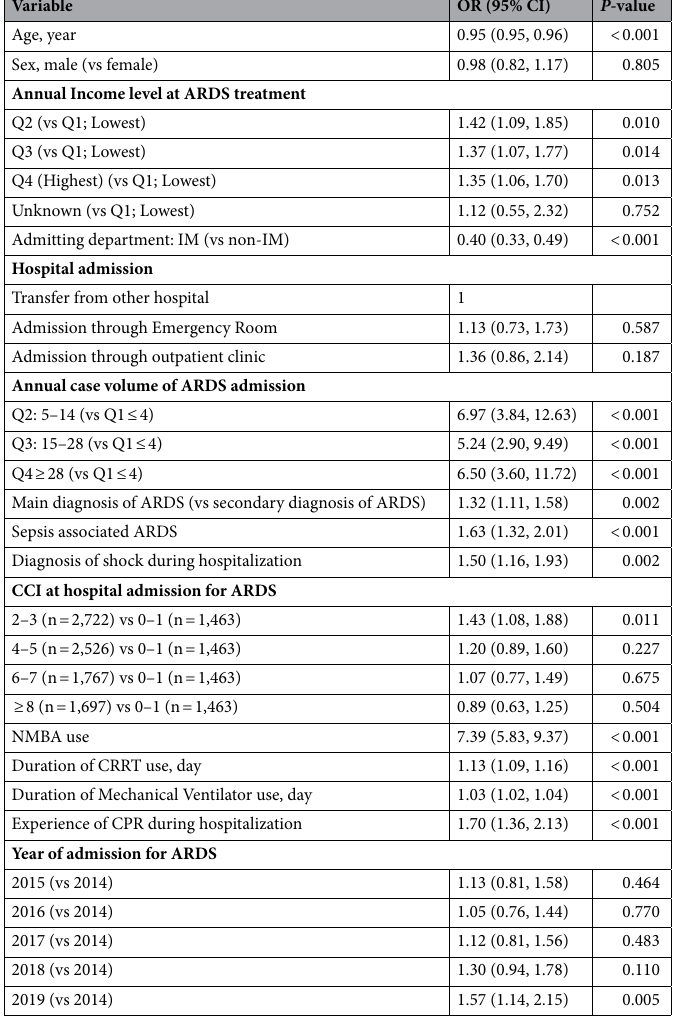
Table 3. Multivariable logistic regression model for ECMO support in patients with ARDS. Hosmer Lemeshow test: Chi-square, 3.66, df = 8, P = 0.886. ARDS acute respiratory distress syndrome, ECMO extracorporeal membrane oxygenation, OR odds ratio, CI confidence interval, IM internal medicine, USD United States Dollars, NMB neuromusclar blockade, CRRT continuous renal replacement therapy, CPR cardiopulmonary